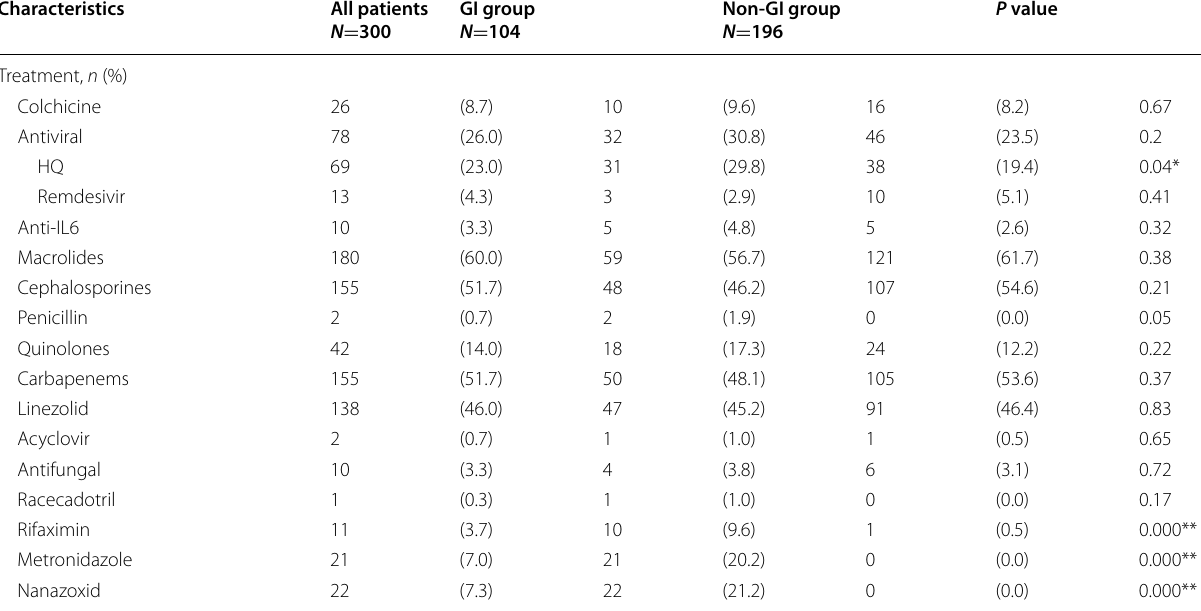
Table 2 Treatment of patients with COVID-19